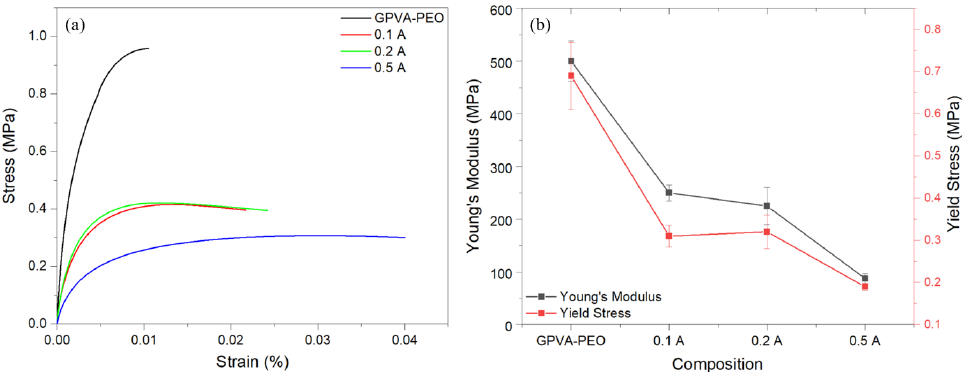
Figure 5. ( a ) characteristic stress-strain behavior of the substrates, ( b ) elastic modulus (E) and yield